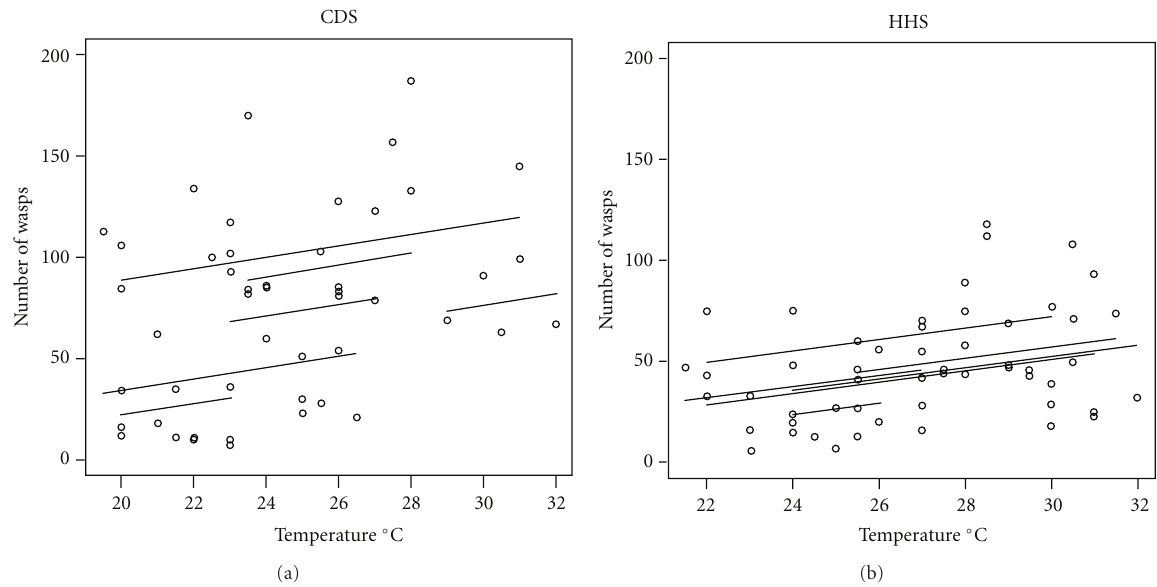
Figure 3: Number of foragers that arrived at the nest every 15 minutes in relation to season and temperature. There is a clear influence of temperature on foraging for both. Lines were estimated by linear mixed e ff ect (LME) model, according to the equation: Number of wasps foraging = − 29.98 + 28.79 × Season + 2.82 × Temperature + Random e ff ect + Residual, where Random e ff ect ∼ N (0, 23.04) and Residual ∼ N (0, 28.06). CDS: cold and dry season. HHS: hot and humid